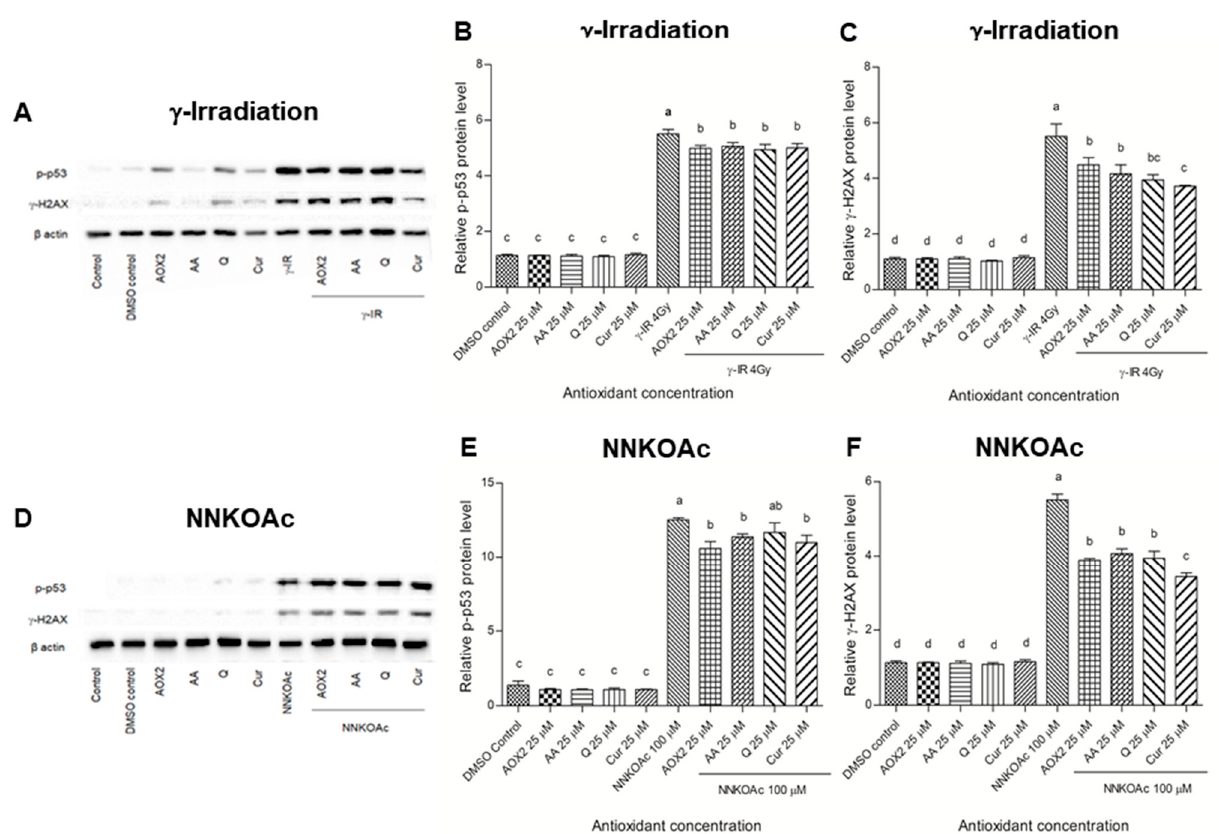
Figure 7. Effect of tested antioxidants on DNA damage repair signaling proteins in BEAS-2B exposed to γ -irradiation ( A – C ) or NNKOAc ( D – F ). Phosphorylated p53 (p-p53, B , E ) and phosphorylated H2AX ( γ -H2AX, C , F ) were assessed by Western blotting. The relative amount of each protein expression level of p-p53 and γ -H2AX was calculated with respect to beta-actin protein. Experimental values are mean ± SD of three independent experiments in triplicate. One-way analysis of variance was performed with Tukey’s pairwise comparison. Means that share the same letter are not significantly different at p ≤ 0.05. Abbreviations: AOX2, dietary antioxidant formulation-2; AA, ascorbic acid; Q, quercetin; Cur, curcumin; DMSO, dimethyl sulfoxide; γ -IR, γ -irradiation.